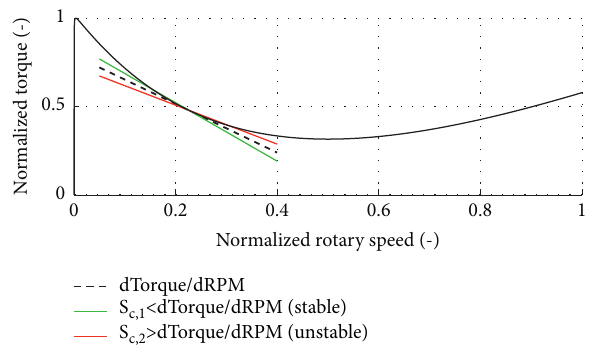
Figure 1: Nonlinear torque characteristic with lines at the oper- ating point c.f. [9,